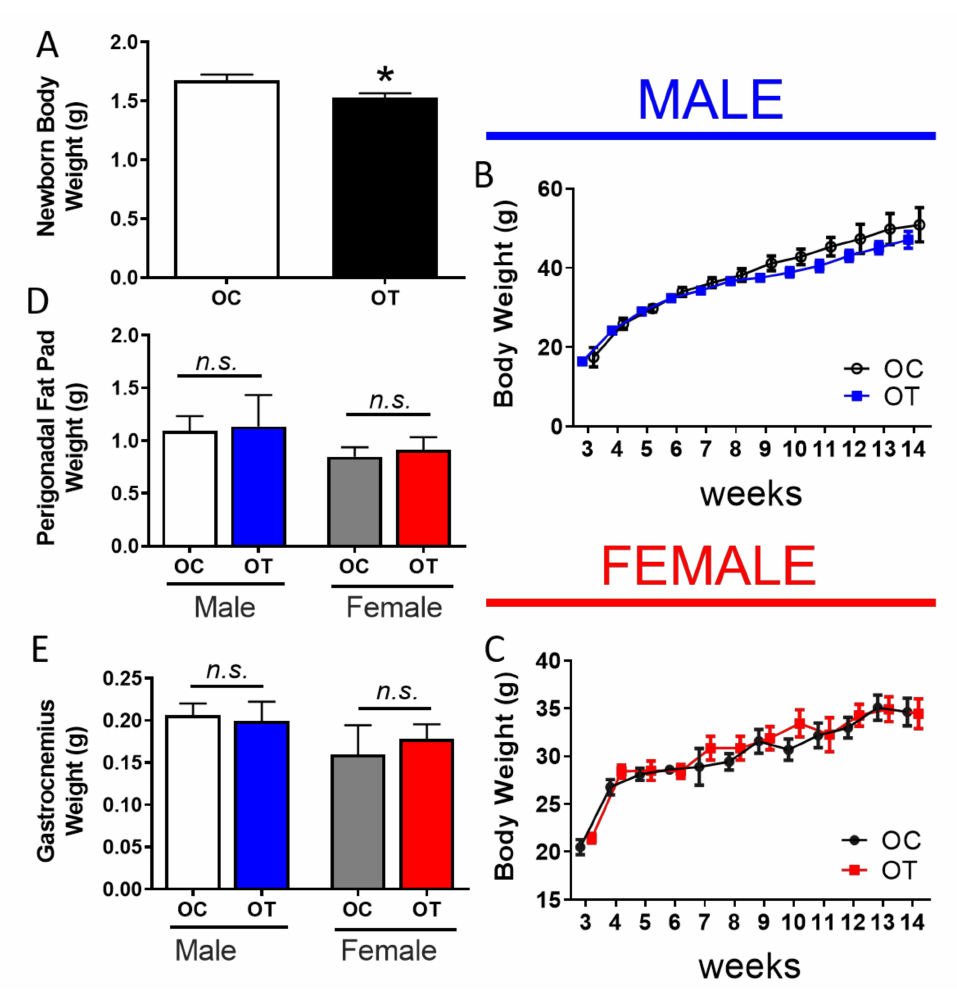
Figure 2. Offspring body composition.( A ) Newborn body weight of OC mice (white bar) and OT mice (black bar). ( B ) Body weights were assessed for 12 weeks, from weaning (week 3) to euthanasia (week 14) in OC male (open circles) and OT male offspring (blue squares). ( C ) Body weights were assessed for 12 weeks, from weaning (week 3) to euthanasia (week 14) in OC female (black circles) and OT female progeny (red squares). ( D ) Perigonadal fat pad weights of OC male mice (white bar), OT male mice (blue bar), OC female mice (gray bar), and OT female mice (red bar). ( E ) Gastrocnemius weight of OC male mice (white bar), OT male mice (blue bar), OC female mice (gray bar), and OT female mice (red bar). Data are presented as the mean ± SEM. * p ≤ 0.05, n.s. = non-significant vs. OC using two-tailed t -test. n = 12 (panel A ) n = 6 (panel B – E